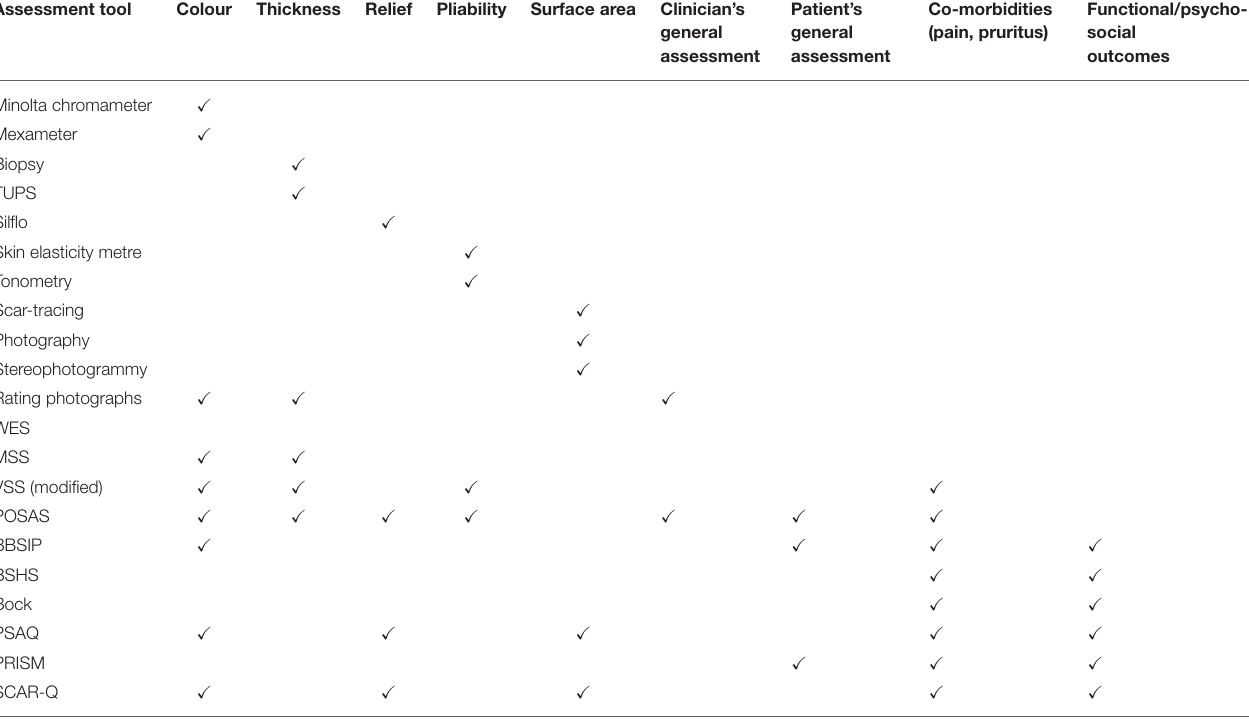
TABLE 1B | Criteria of current assessment tools. Assessment